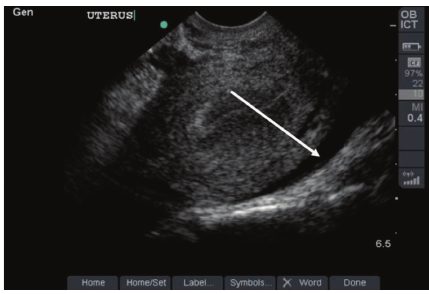
Figure3:Pelvicultrasounddemonstratesthesamehypoechoicfluid collection posterior to the uterine wall seen on transabdominal ultrasound in Figure 2.